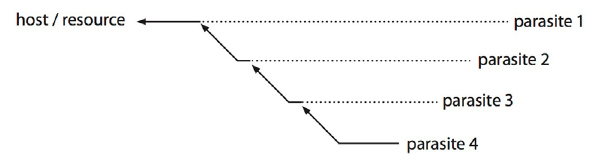
FigUre 2 | Parasites as “relational atoms,” images as parasites—Note the difference between continuous (actual) and dotted (virtual) lines, as well as the dominance of one-way